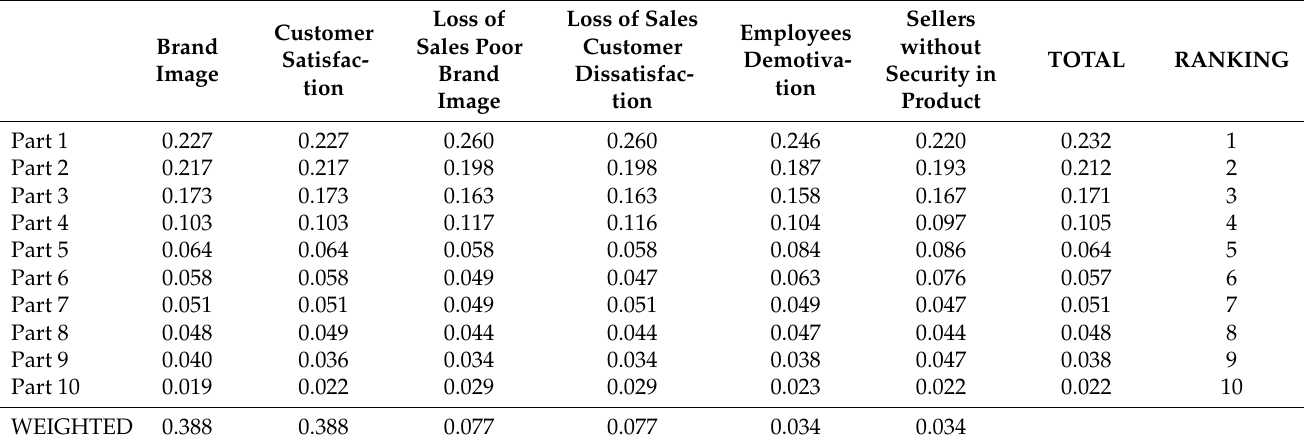
Table 4. Example of the AHP result of a